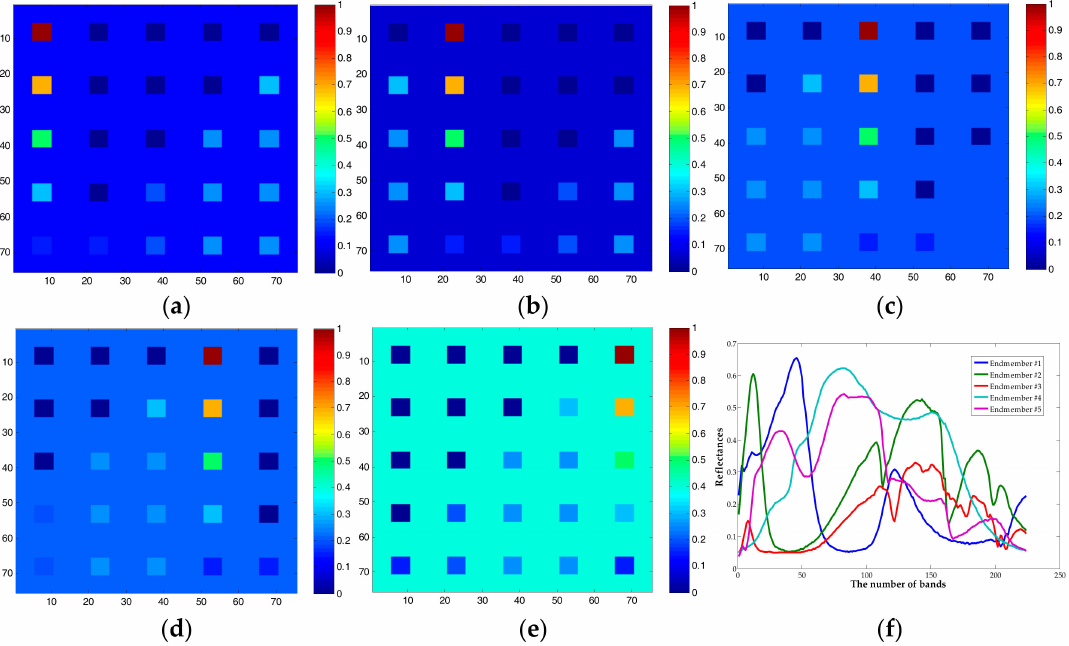
Figure 2. Simulated dataset S-1. ( a ) Abundance map of #1. ( b ) Abundance map of #2. ( c ) Abundance map of #3. ( d ) Abundance map of #4. ( e ) Abundance map of #5. ( f ) The five